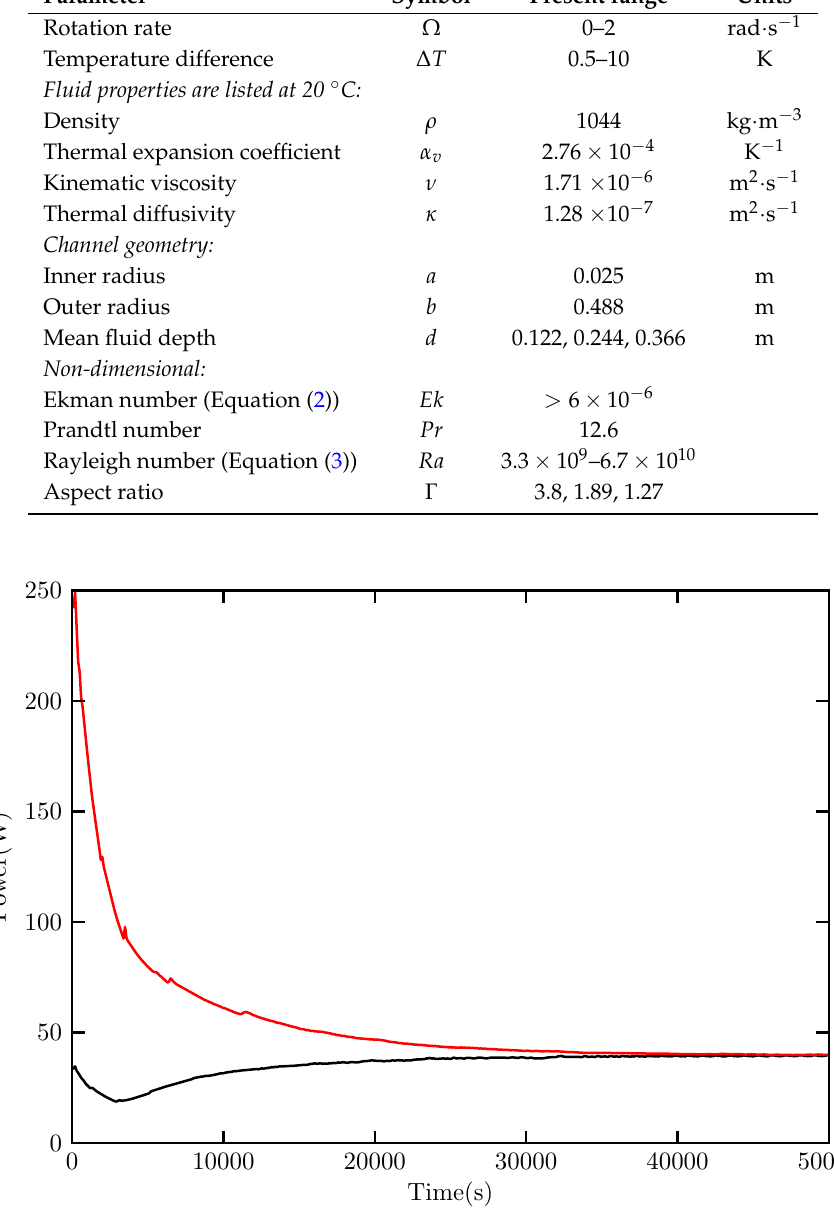
s − 1 and d = 24.4 cm. The red ·